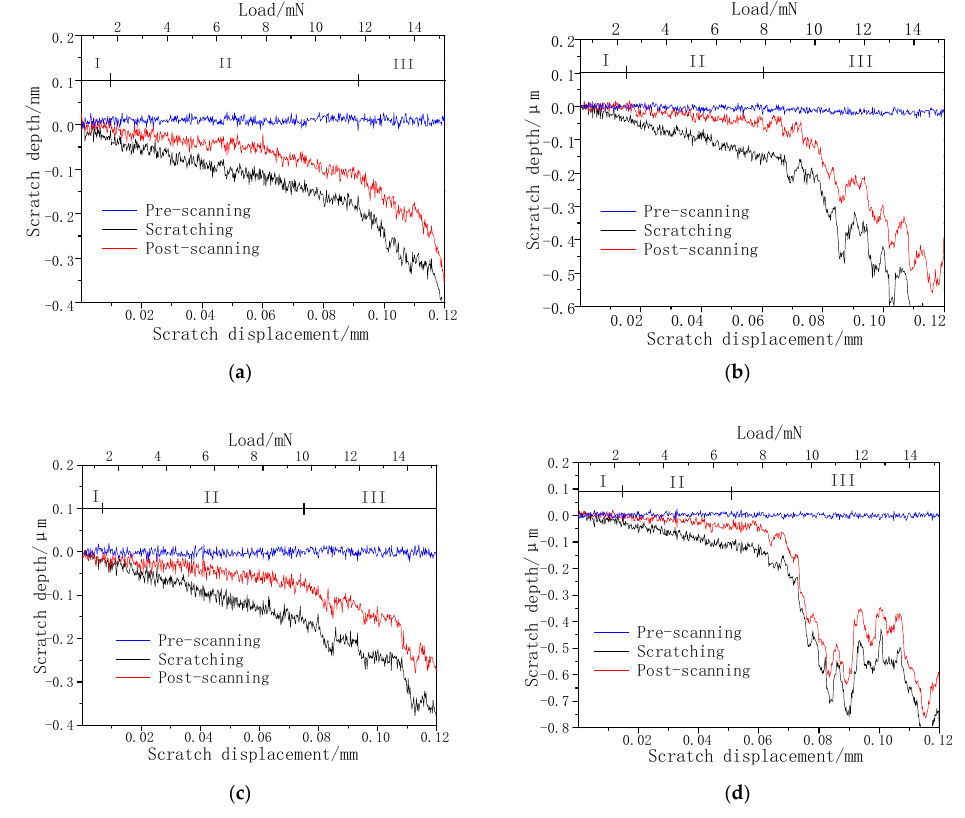
Figure 9. Scratch depth-displacement-load along different orientations: ( a ) X axis on Z-cut, ( b ) Y axis on Z-cut, ( c ) Y axis on X-cut, ( d ) Z axis on X-cut, of pre-scratching (I represents the elastic deformation stage, II represents the ductile deformation stage, and III represents the brittle deformation stage.).